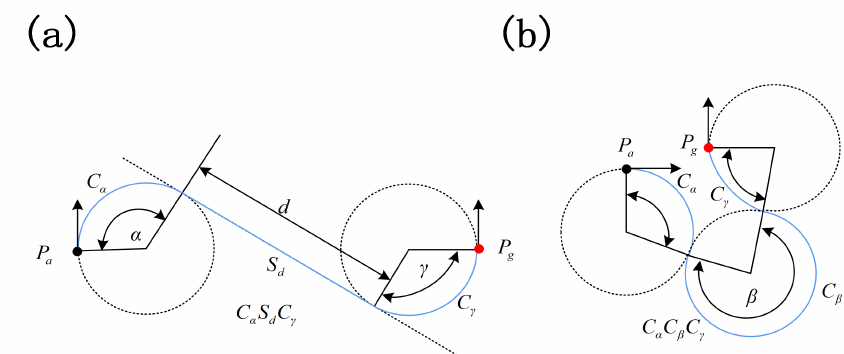
Figure 1. Dubins path: ( a ) CSC curve and ( b ) CCC